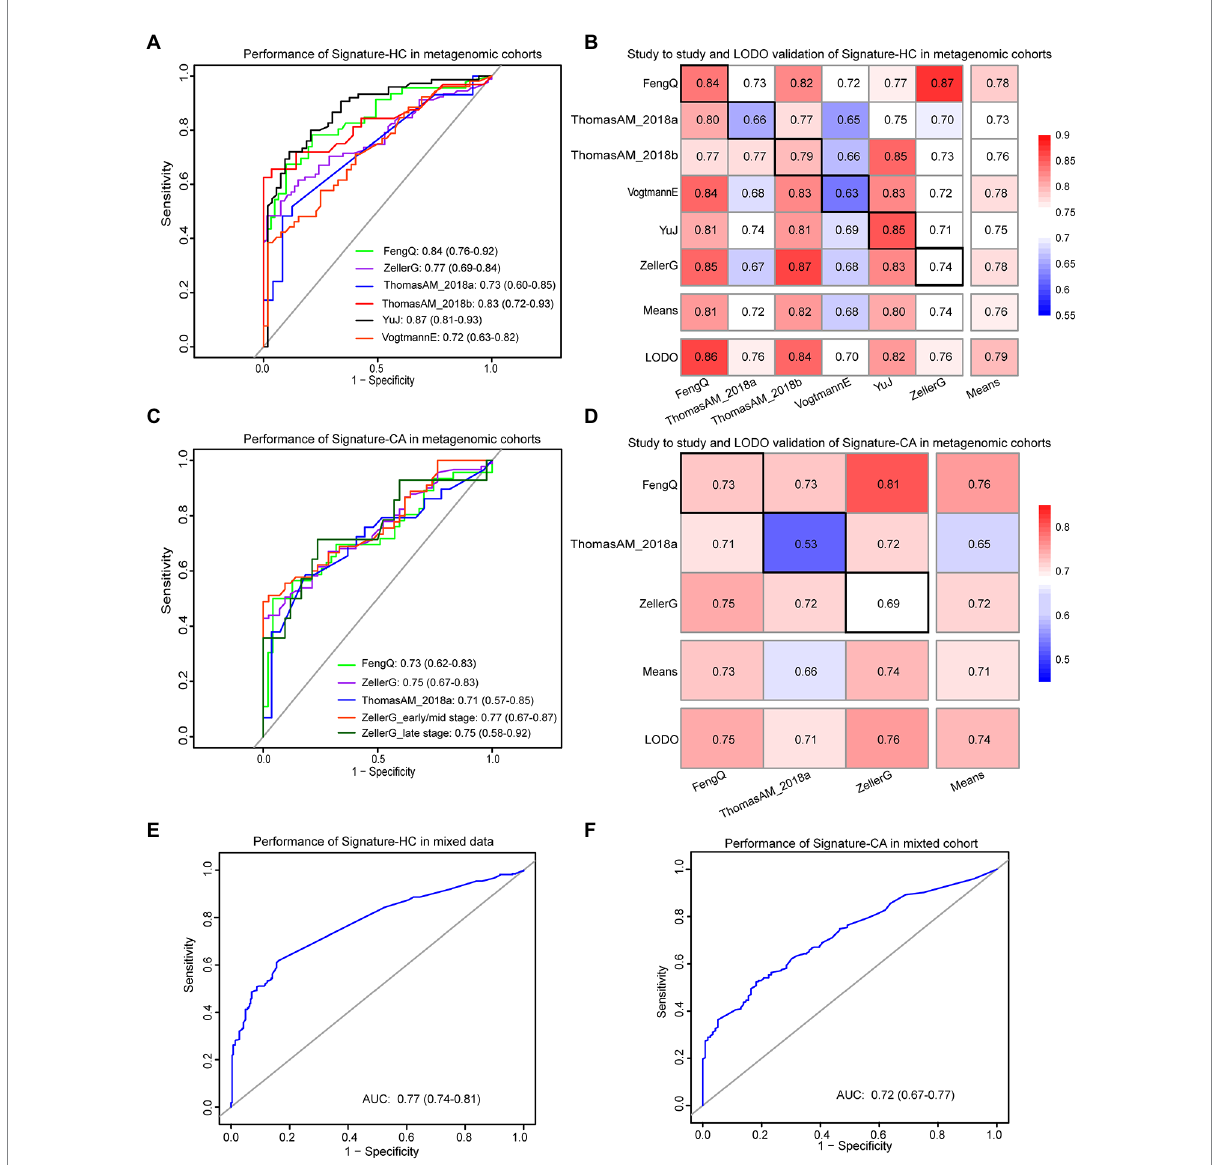
FIGURE 5 The performances of signature-HC and signature-CA across metagenomic data. (A) Performance of the signature-HC across six metagenomic sequencing cohorts. (B) The classification accuracy of signature-HC resulting from study-to-study transfer and LODO model. Values on the diagonal (black boxes) refer to the AUC values by training the model in the study of the corresponding row, while off-diagonal values refer to the AUC values by testing the model in the study of the corresponding column. The LODO rows refer to the AUC values obtained by the model on universal genera, using all but the study of the corresponding column and applying it to the study of the corresponding column. (C) Performance of the signature-CA across three metagenomic sequencing cohorts. (D) The classification accuracy of signature-CA resulting from study-to-study transfer and LODO model. (E) Performance of the signature-HC in the mixed data. (F) Performance of the signature-CA in the mixed